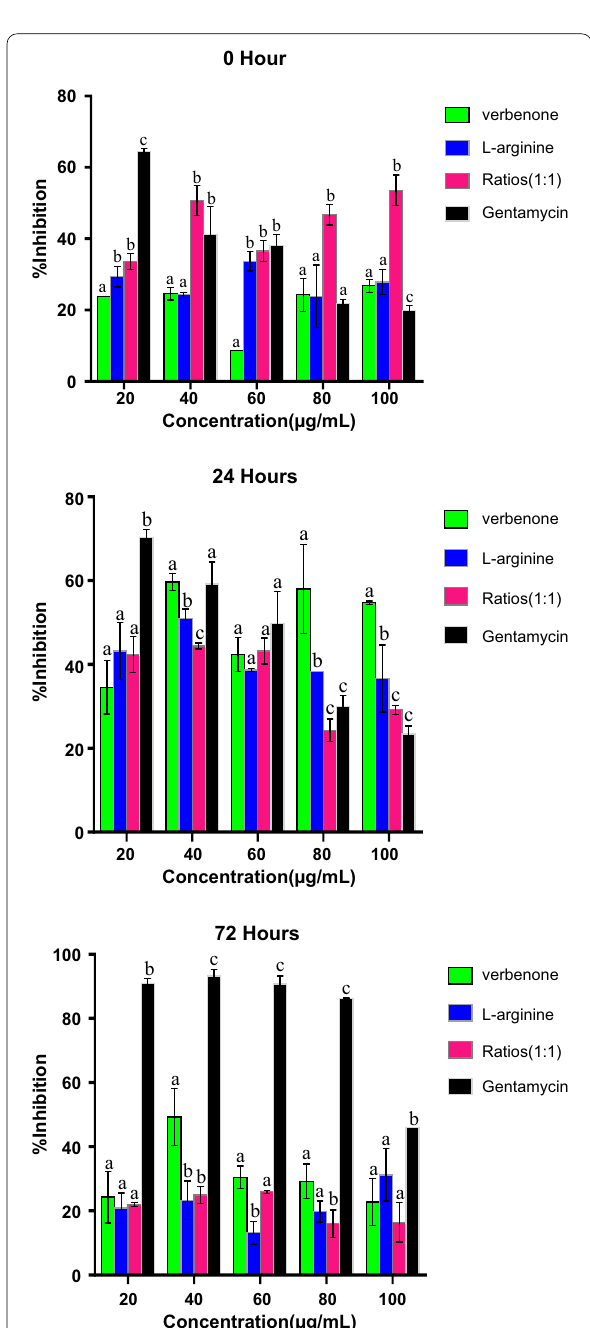
Fig. 5 Haemoglobin Glycosylation inhibitory activity of verbenone, L-arginine and ratios of verbenone 72 h incubation. Values are expressed as mean determinations. Values with different superscripts are significantly different at p < 0.05. Ratios (1:1)